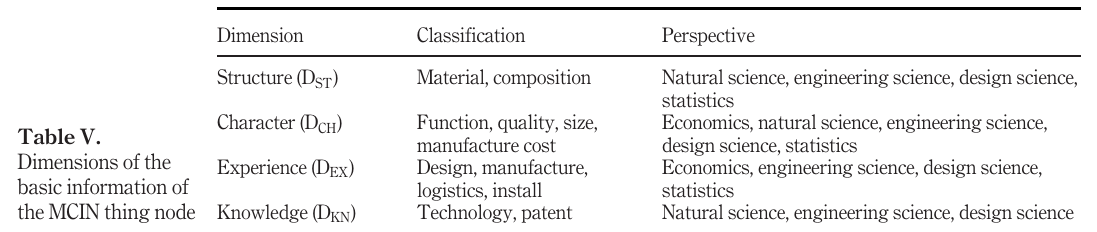
Table IV. Dimensions of the basic information of the MCIN